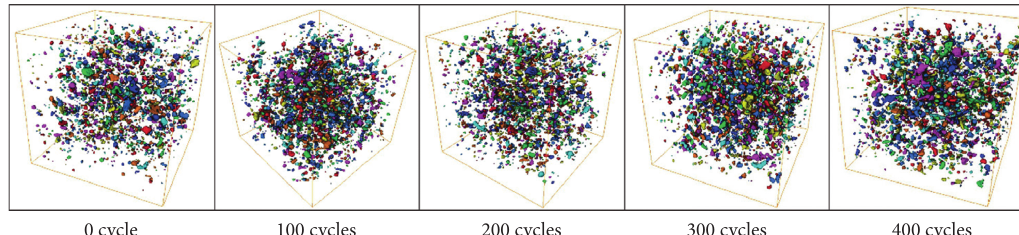
Figure 14: Cube-pore image of 0% CaO expansive concrete (C-0) under different freeze-thaw